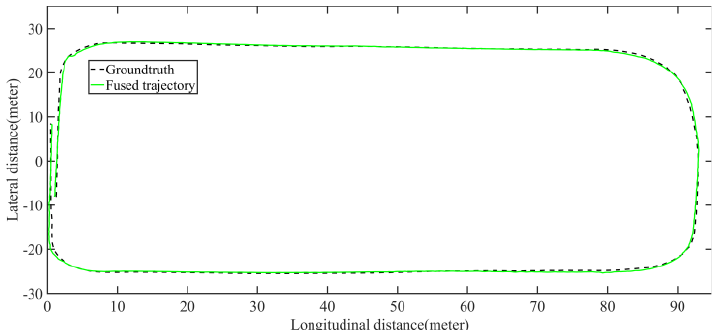
Figure 20. Field test NO.1. One lap under normal driving scenario localization test in prior point cloud map. The white points in the figure are the point cloud map built by the offline mapping process, the red line is the trajectory of LiDAR matching results, the orange line is groundtruth, and the blue line is the fused trajectory.